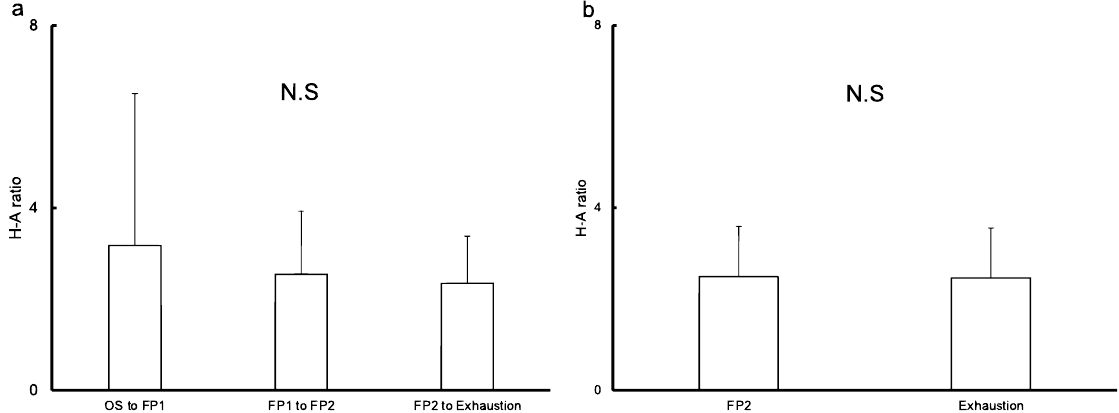
Figure 3. Regional difference in mean local sweat rate in each duration based on two flexion points of sweat rate. This graph shows the ratio of the mean local sweat rate on the forehead to that on the upper arm in each section, segmented by two inflection points, from the onset of sweating until exhaustion. The ratio tended to decrease over time, although there was no significant difference ( a ), while a slight change was observed from the second flexion point to exhaustion. There was little change of the ratio of the time from exercise start to each time point detected on the forehead to that on the upper arm ( b ). Abbreviations: FP, flexion point; OS, onset of sweating; H-A ratio, the ratio of mean local sweat rate on the forehead to that on the upper arm, N.S, not significant.